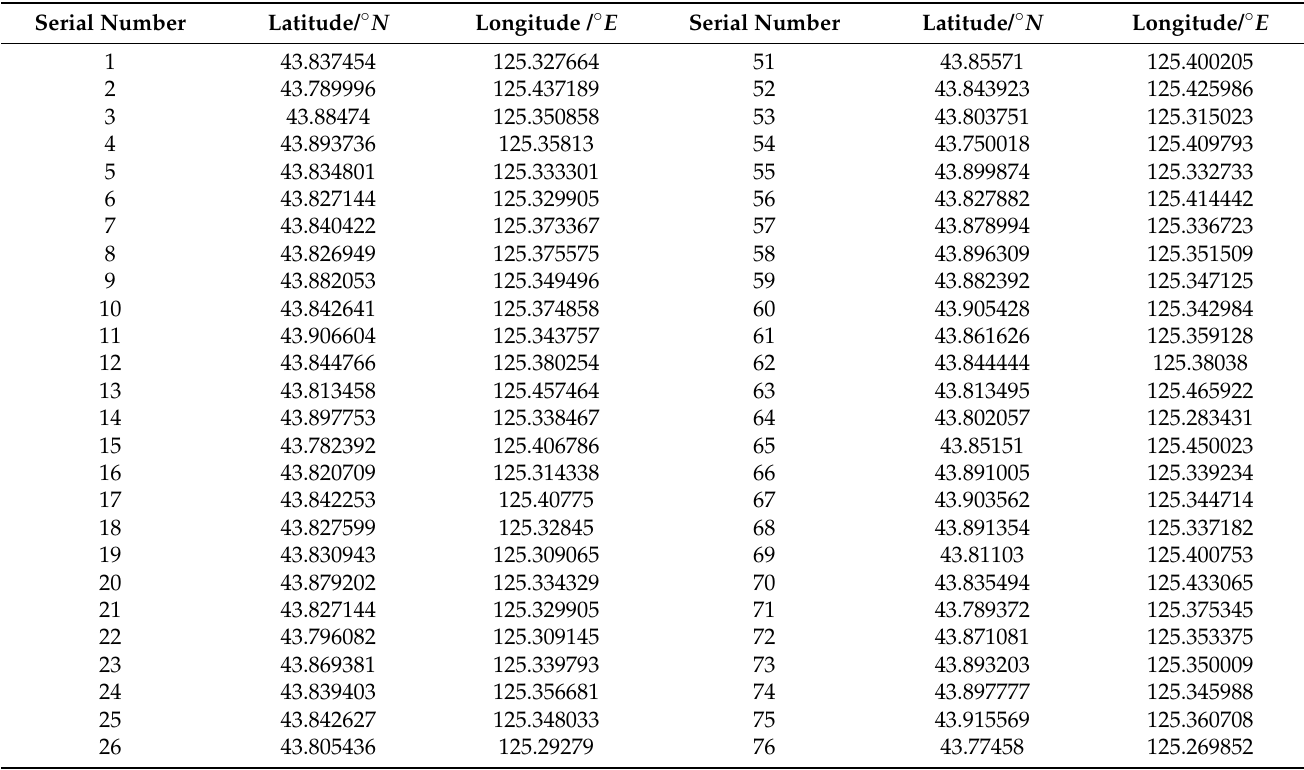
Table A3. Location of express points in Nanguan